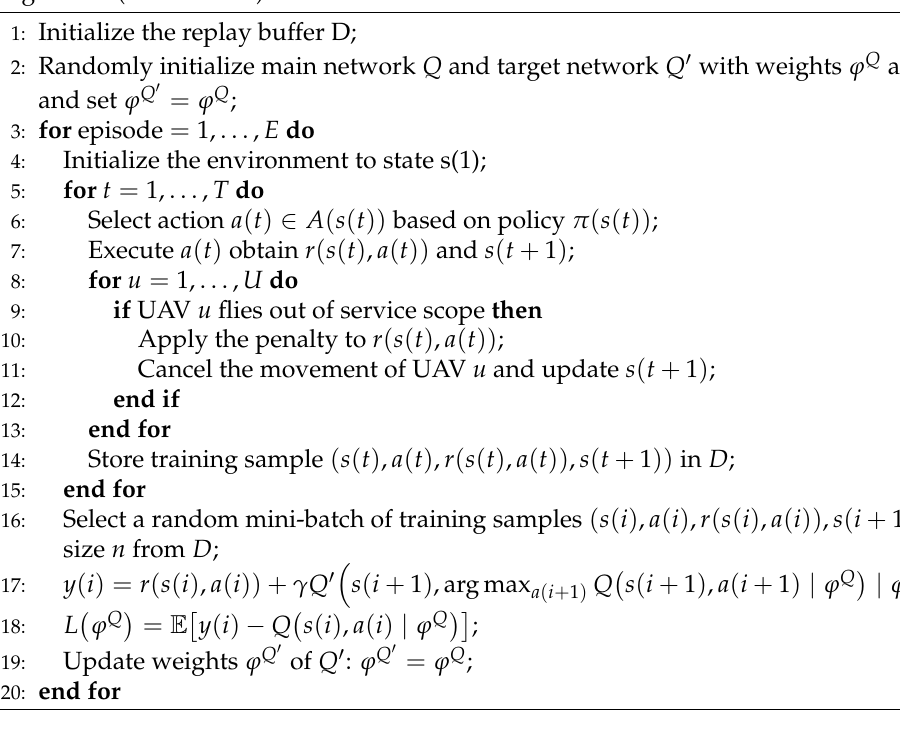
Algorithm 1 Deep Reinforcement Learning-Based UAV Cluster-Assisted Task-Offloading Algorithm